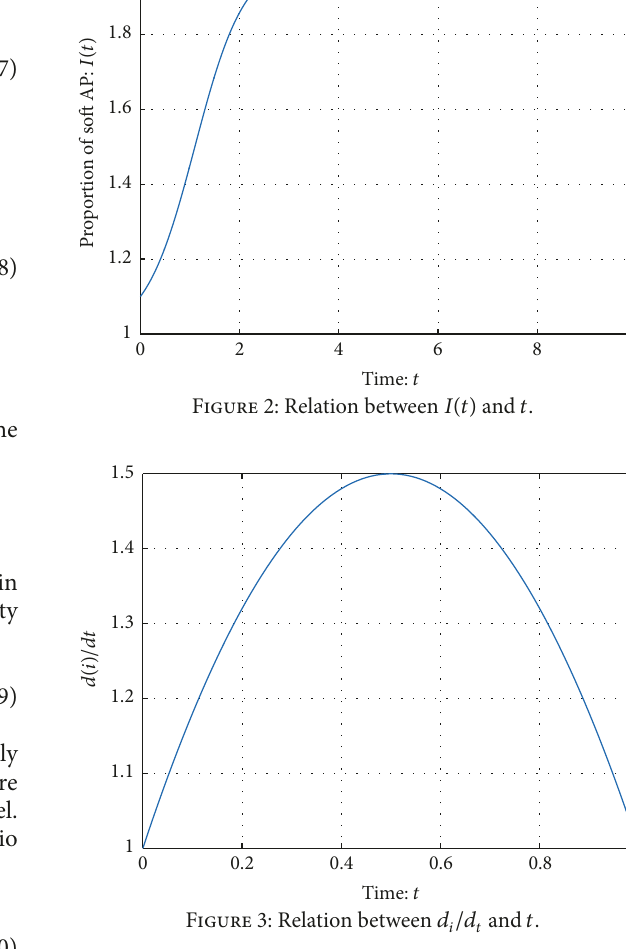
Figure 4 is calculated with MATLAB. In the calculation, 𝑁 is set to be 10, and file size 𝐿 is set to be 4